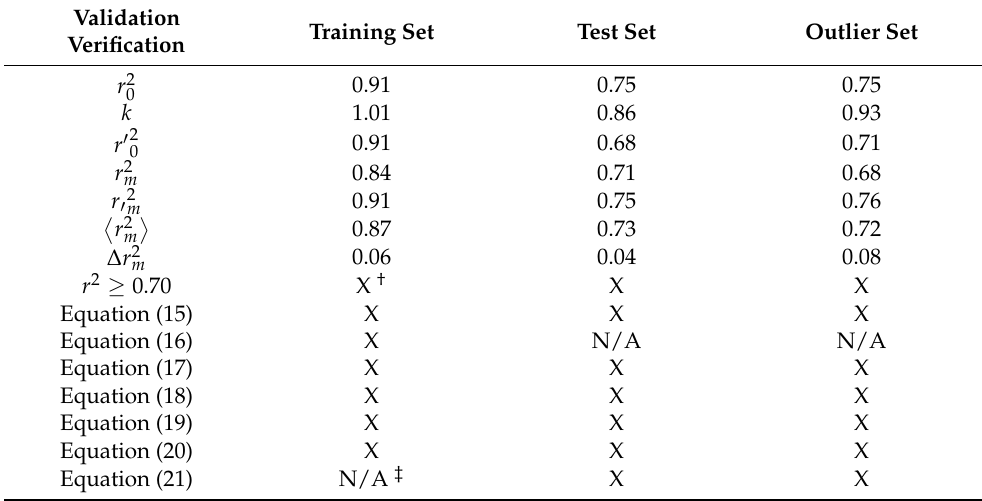
Table 5. Validation verification of HSVR based on prediction performance of the training, test, and outlier